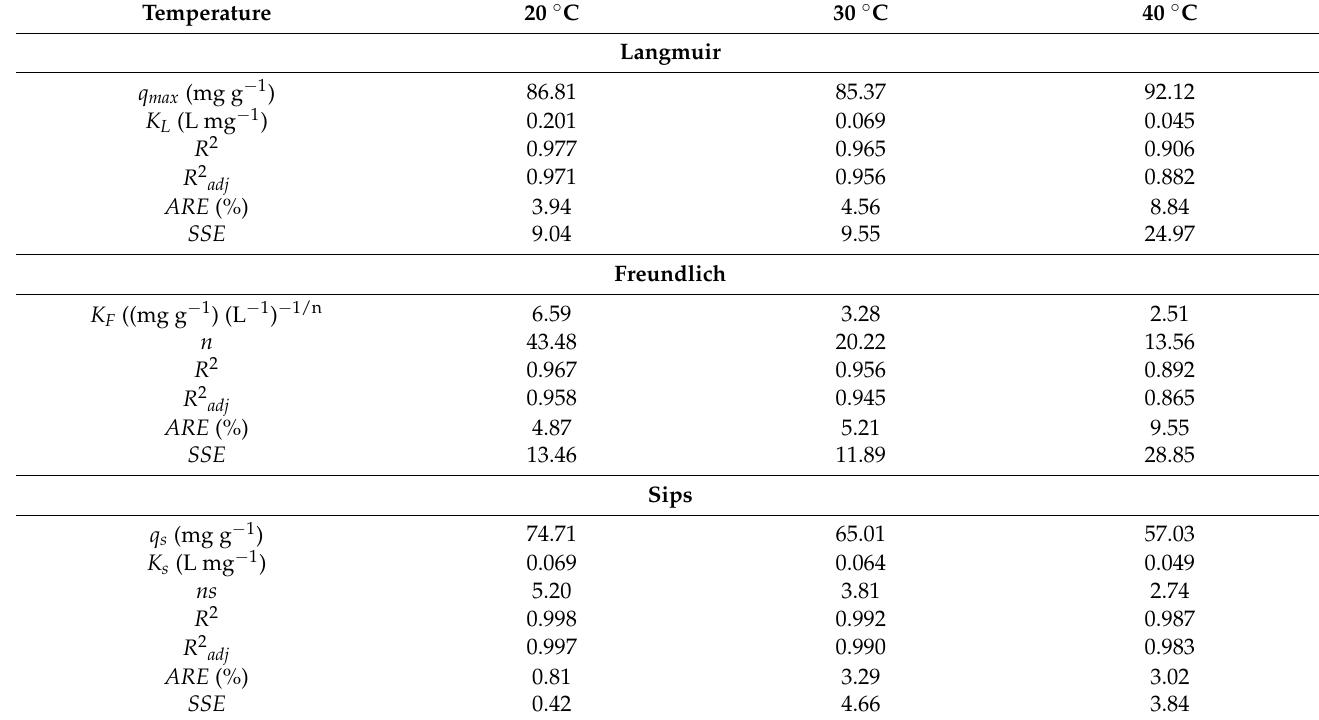
Table 2. Equilibrium parameters for TC adsorption on CS · Fe 3 O 4 .